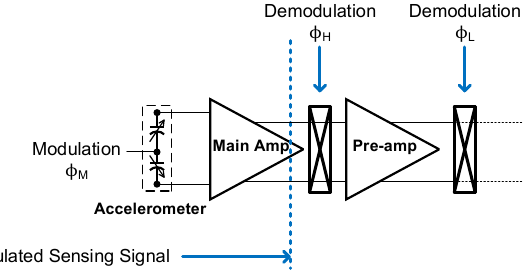
Figure 4. The simplified architecture in Reference [1].